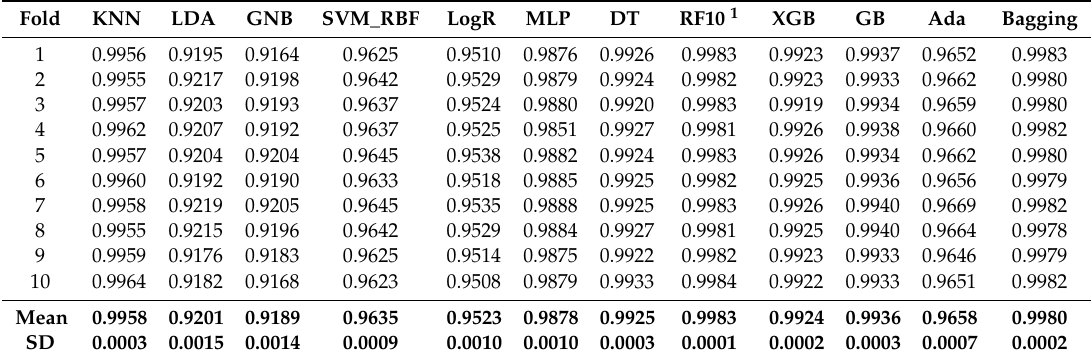
Table 2. AUROC for Net-Net AutoML classification models.